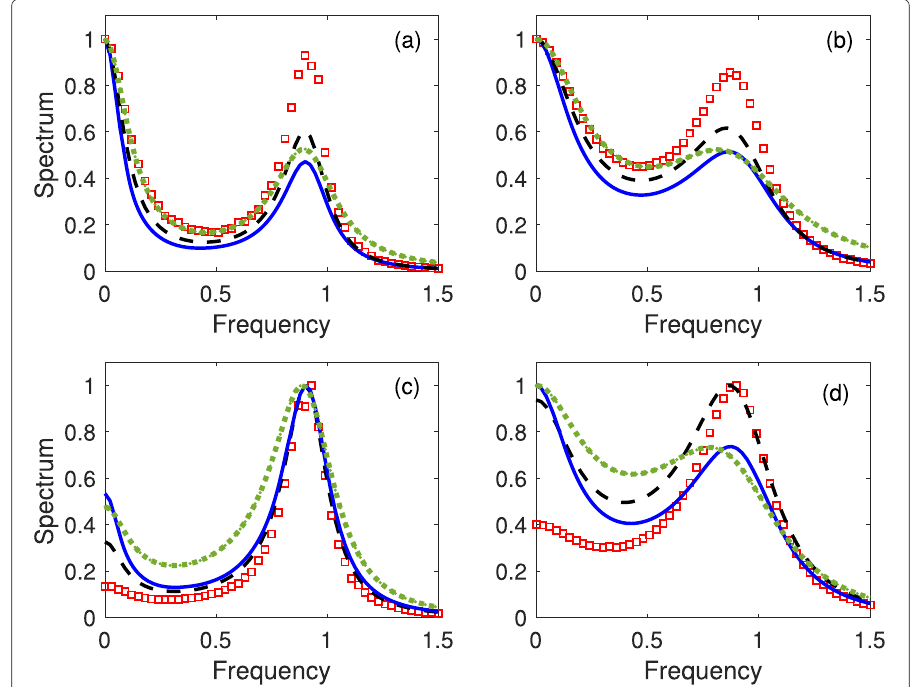
Fig. 5 Spectra of the spontaneous (a, b) and coherent (c, d) RBS, when (a, c) Kn = 0.02 and (b, d) Kn = 0.04. Solid and dashed lines are the results from Brenner’s bi-velocity equations with a ∗ in Eq. 30 being 3/2 and 1, respectively, while the dotted lines are results from the extended NS equations